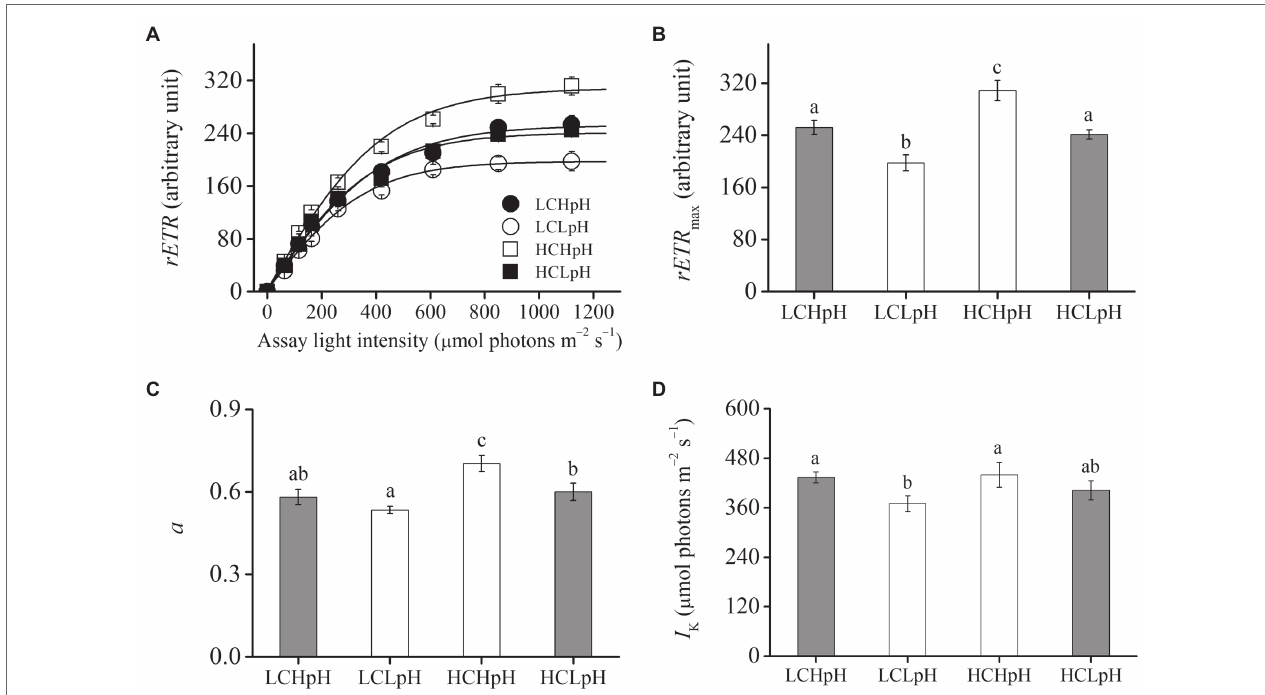
FIGURE 2 | (A) Relative electron transport rate ( rETR ) as a function of the assay light intensity (0–1,120 μ mol photons m − 2 s − 1 ), (B) maximal relative electron transport rate ( rETR max ), (C) light use efficiency ( a ) and (D) saturating light intensity ( I k ) of E. huxleyi RCC1266 under the LCHpH (gray), LCLpH, HCHpH, and HCLpH (gray) treatments. Different letters (a, b, c) in each panel represent significant differences between four treatments (Tukey Post hoc , p < 0.05). For more information, please see Figure 1 .